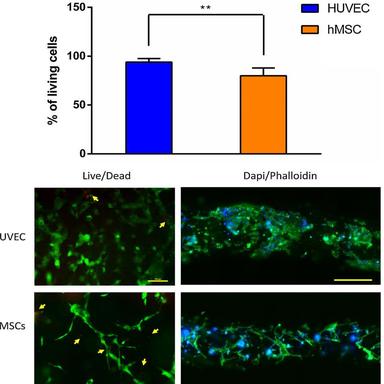
Microscopy images of live/dead and dapi/phalloidin staining for HUVEC and hMSCs cells loaded into the ZS-EI-ELR and bioprinted. For dapi/phalloidin staining, the maximum intensity of the Z stacking is shown. Scale bar for the live/dead: 100 m; for dapi/palloidin XXX. Viability of the bioprinted cells was also measured and represented in the graph above. (ns P > 0.05; \P < 0.05; \\P < 0.01; \\\P < 0.001; \\\\P < 0.0001).